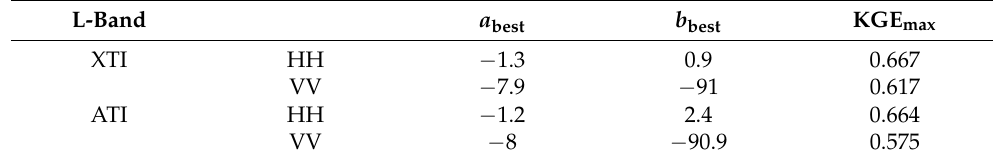
Figure 9. Simulated versus observed field average bare soil SAR bistatic scattering in ATI flight configuration for HH ( left ) and VV ( right ) polarization. Bistatic scattering simulations are performed with the physically-based AIEM and in situ measured roughness parameters. Table 4. Regression model parameters for estimating the effective l -values for the AIEM from normalized bistatic scattering observations, whereby s is set at 1.75